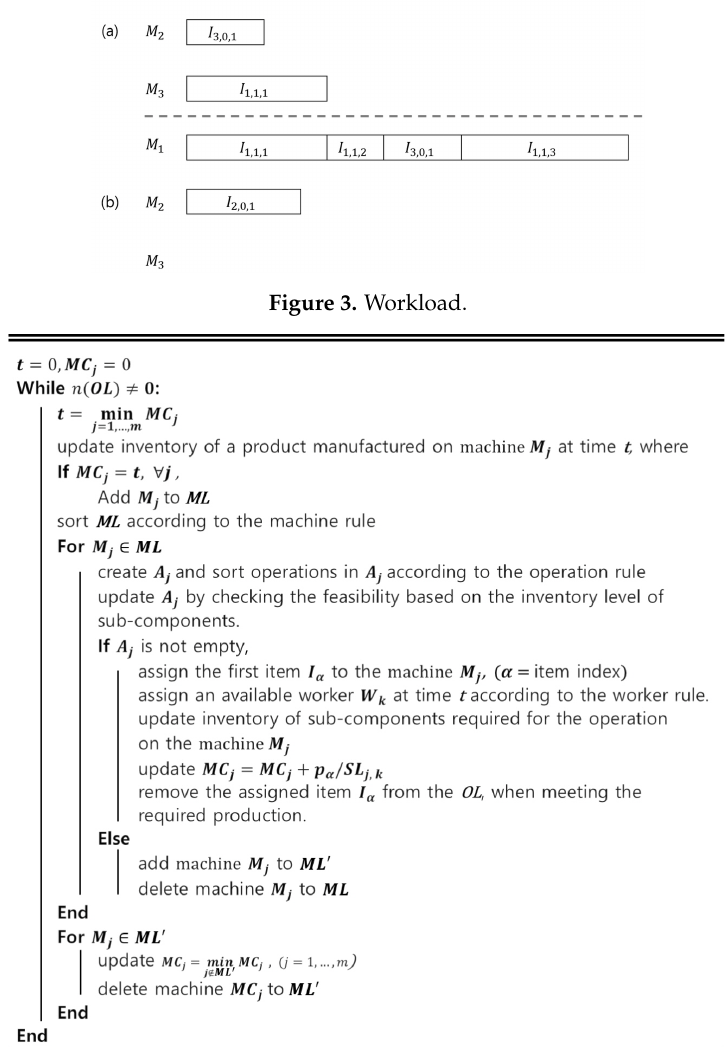
Figure 4. Pseudocode for initial solution